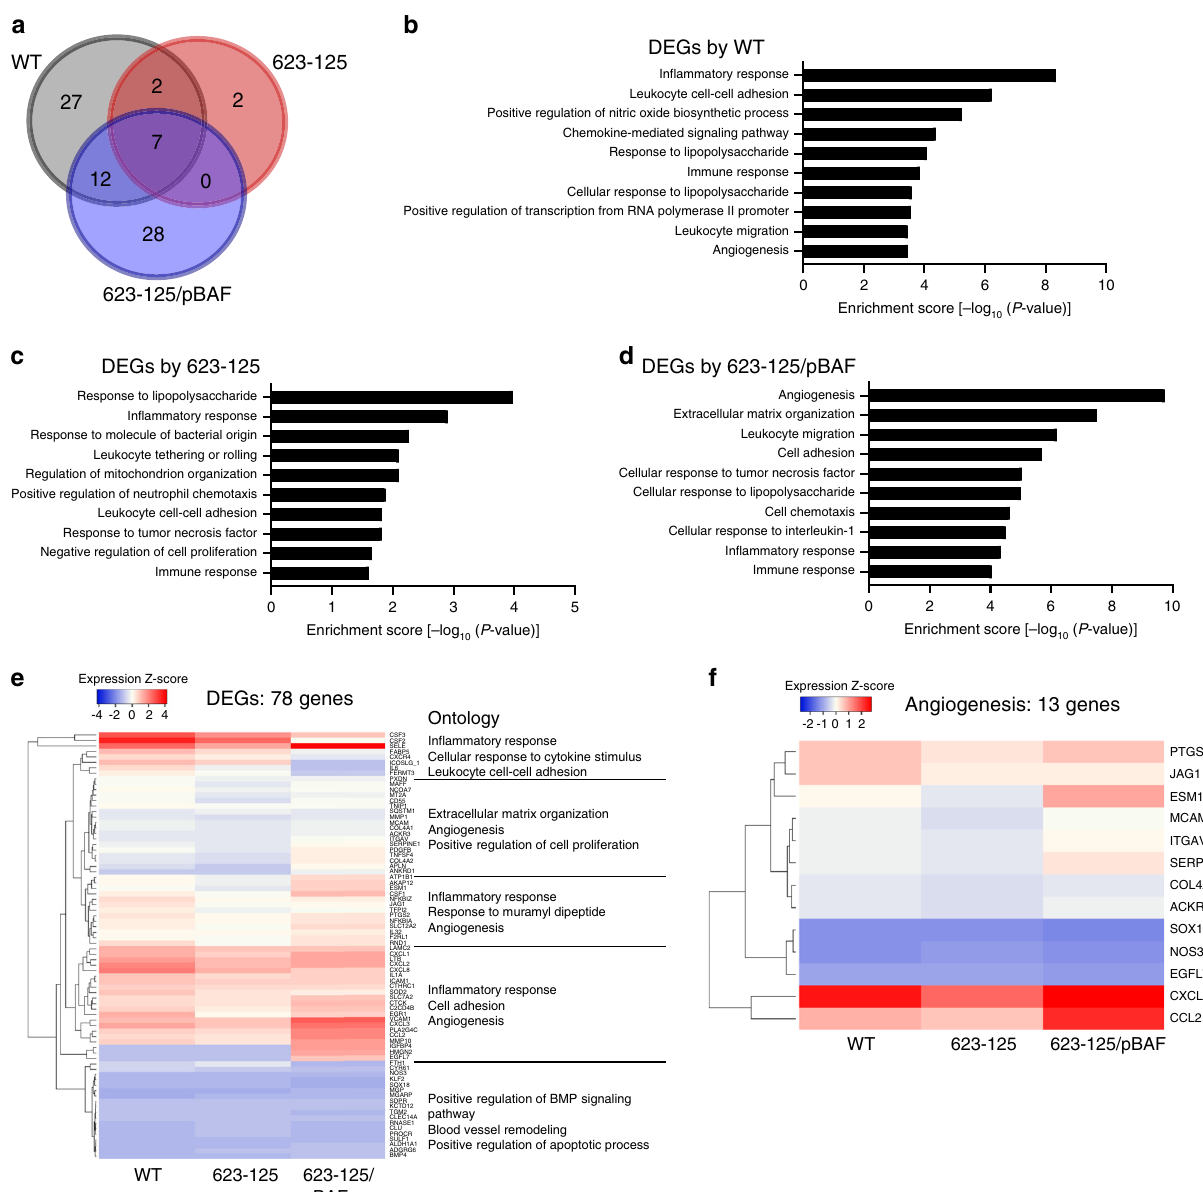
Fig. 2 The bafA gene affects angiogenesis-related gene expression in endothelial cells. a Venn diagram showing the overlap among differentially expressed genes (DEGs; fold change compared with uninfected HUVECs >1.5, three biological replicates) in HUVECs co-cultured with three Bh strains: WT (gray), 623-125 (red), or 623-125/pBAF (blue). b – d Enrichment of GO categories among DEGs in HUVECs co-cultured with Bh -WT ( b ), 623-125 ( c ), or 623-125/pBAF ( d ). e Heatmap representation of expression of all DEGs and selected enrichment GO terms for each cluster. f Heatmap of angiogenesis- related genes extracted from DEGs. Source data are provided as a Source Data fi